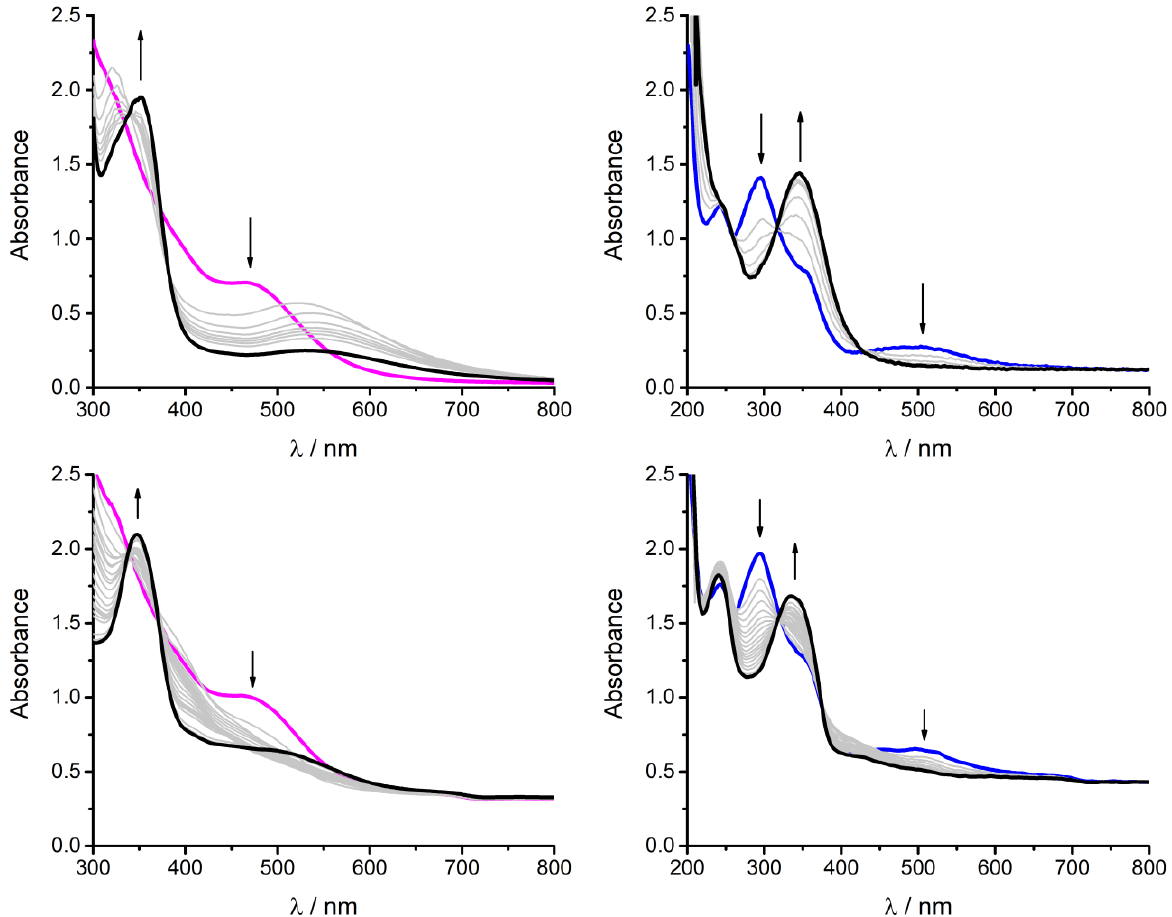
Figure 4. SEC-UV/Vis traces of Fe(salen)Cl ( left ) and of Fe(beacen)Cl ( right ) under N 2 atmosphere ( top panels ) and under CO 2 atmosphere ( bottom panels ), at the potentials corresponding to the generation of the formal Fe I state (−2.21 and −2.24 V vs. Fc + /Fc for Fe(salen) and Fe(beacen), respectively).